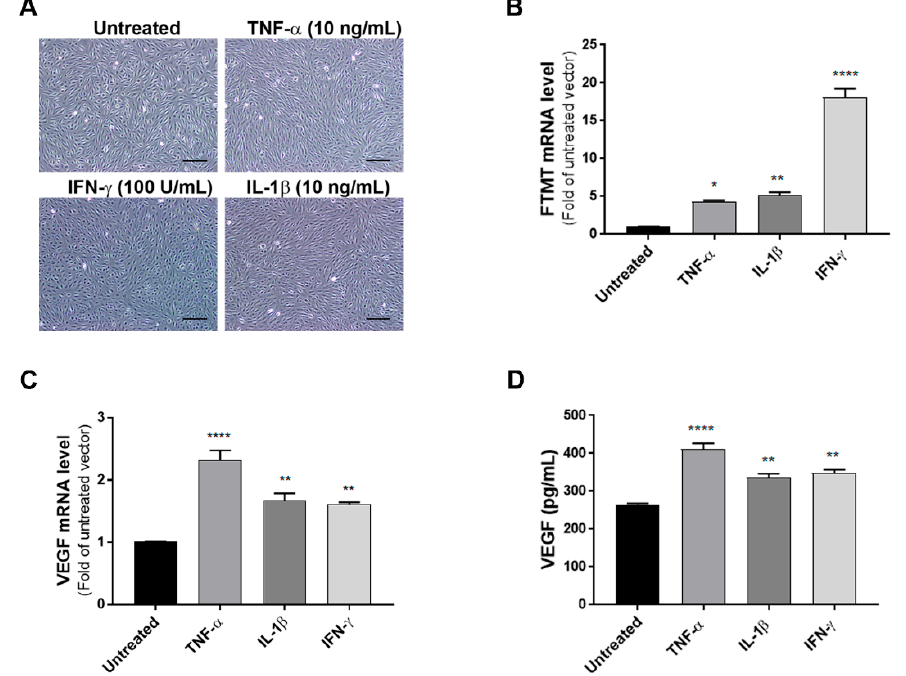
Figure 2. E ff ects of proinflammatory cytokines on the expression of FTMT and VEGF in ARPE-19 cells: ( A ) ARPE-19 cells were treated with TNF- α (10 ng / mL), IL-1 β (10 ng / mL), and IFN- γ (100 U / mL) for 24 h. Scale bars represent 200 µ m. ( B , C ) qPCR results showing the relative mRNA expressions of FTMT and VEGF mRNA expression results were normalized using ACTB. ( D ) Secreted VEGF in the conditioned media was measured using a VEGF ELISA: Data were analyzed by One-way ANOVA with Dunnett’s multiple comparison test. The results shown are the means ± SEM of four independent experiments (* p < 0.05; ** p < 0.01, and **** p < 0.0001).